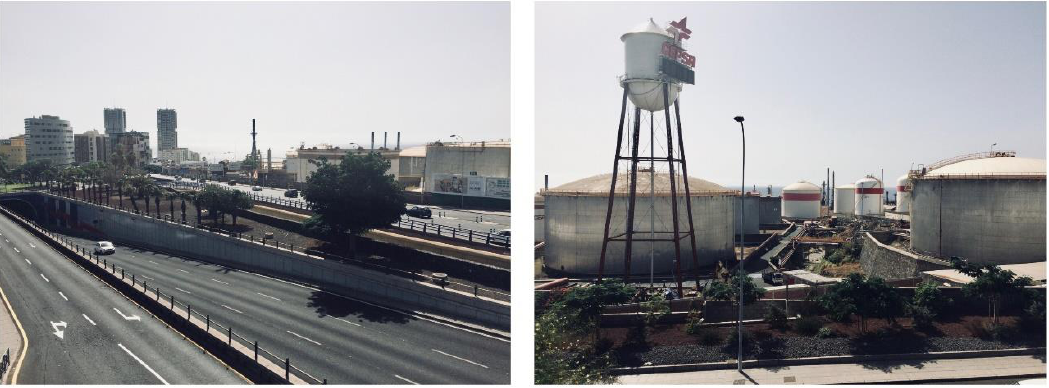
Figure 2. The oil refinery “Tenerife” in Santa Cruz de Tenerife. Own photographs.